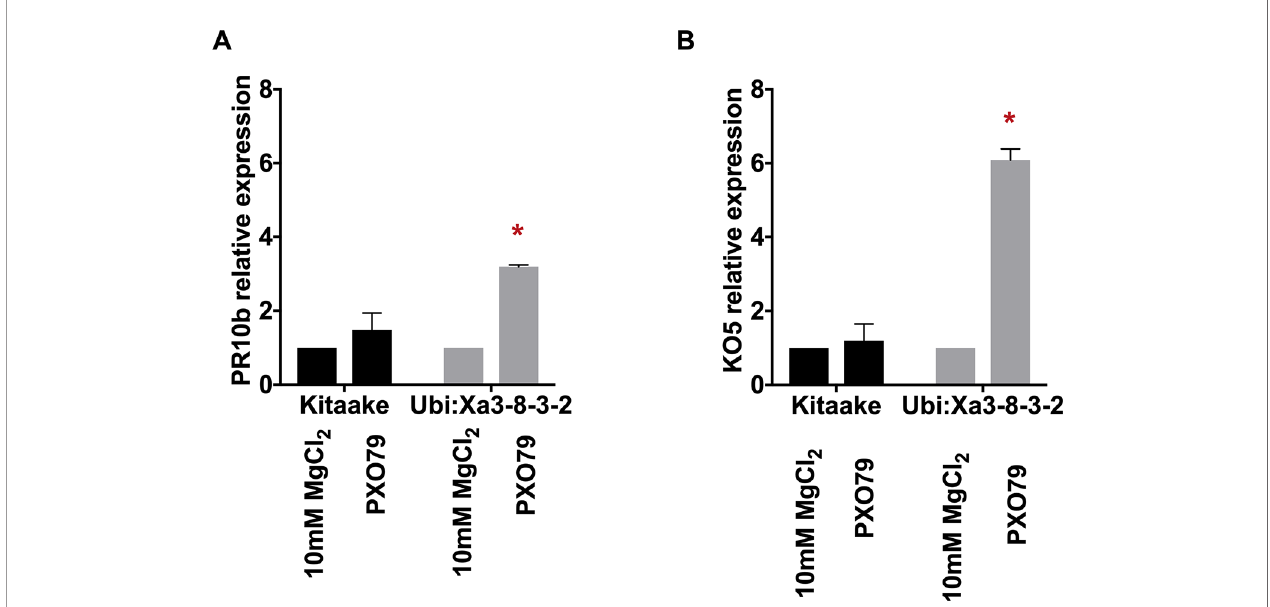
FIGURE 4 | Marker genes are upregulated in detached rice leaves expressing XA3 (Ubi : Xa3-8-3-2) upon Xoo infection. The expression levels of marker genes PR10b (left) and KO5 (right) are normalized to actin and compared to mock-treated samples. Bars indicate the mean expression level standard deviations of three biological replicates. “ * ” indicates a statistically signi fi cant difference using a T test (p <